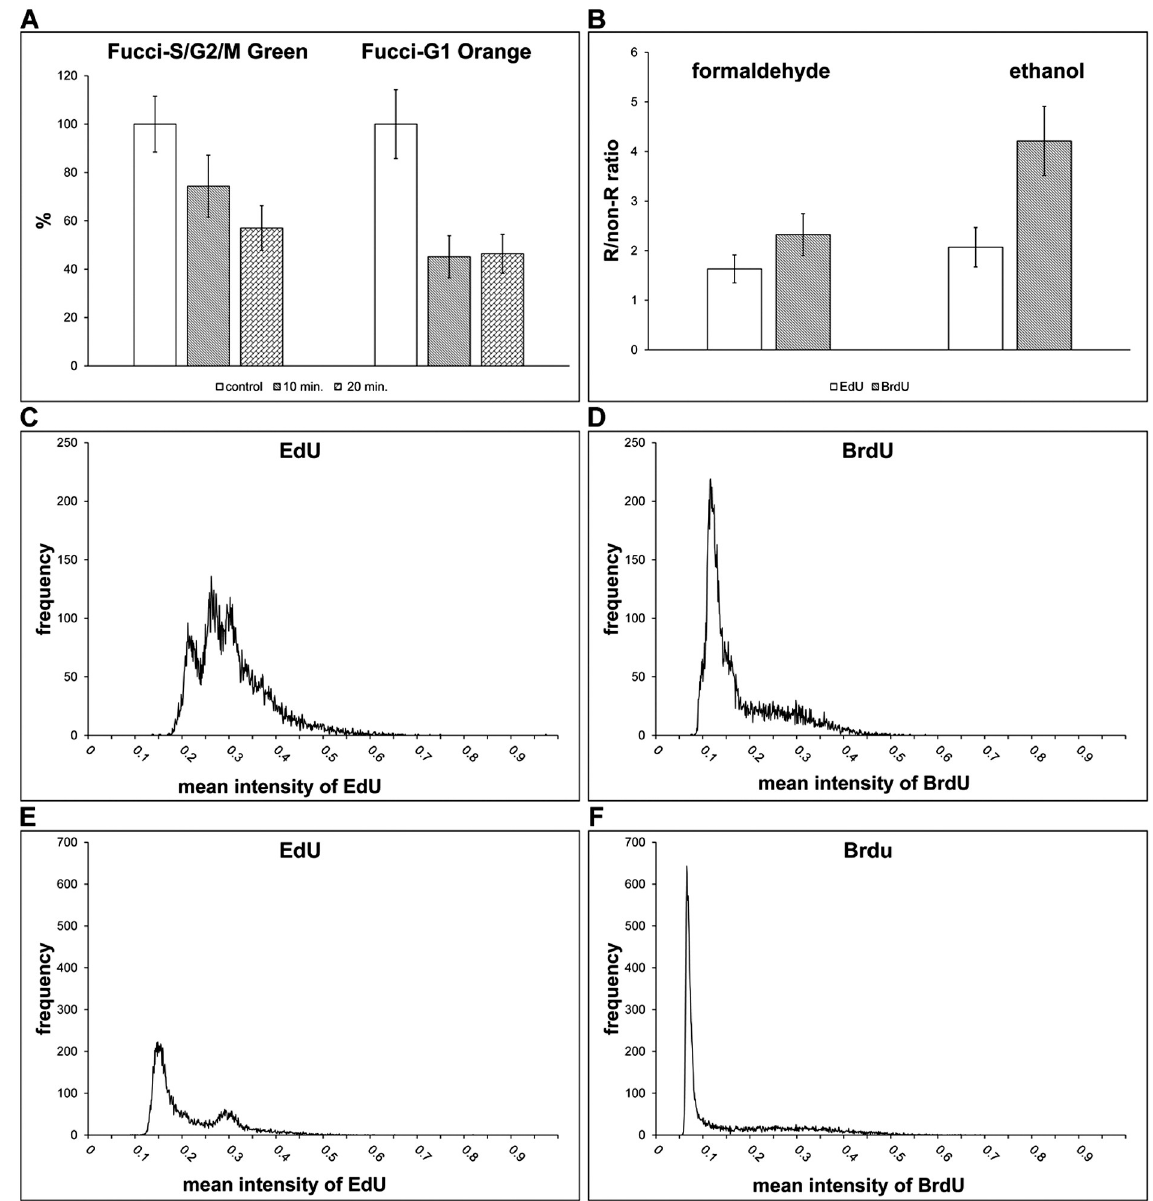
Fig 3. Fluorescent proteins detection and comparison of replicational signal after short pulses of BrdU and EdU. (A) The impact of the optimisedmethod on fluorescentproteins is shown. HeLa cells expressingFUCCI were incubatedwith or without BrdU for 30 minutesand the detectionof BrdU using the optimizedmethod was performed. The cells were treated with HCl either for 10 or 20 minutes. The averagesignalof fluorescent proteins was measuredin cells. The data were normalisedto the % of the average signalof Fucci-G1 Orange and Fucci-S/G2/M Green in control, non-treated, cells. The data are presented as the mean ± SD. ( B) The comparison of the signal in cells labelledwith 10 μ M EdU or BrdU for 5 minutes. The graphsshow differencesbetweencells incubatedeither with EdU or BrdU and fixed either with formaldehyde or ethanol. The data are presented as the mean ± SD. ( C, D) The histograms of the mean nuclear EdU- (C) or BrdU-derived(D) signalsin formaldehyde-fixed cells labelledwith 10 μ M EdU or BrdU for 5 minutes. ( E, F) The histograms of the mean nuclearEdU- (E) or BrdU-derived (F) signals in ethanol-fixed cells labelled with 10 μ M BrdU or EdU for 5 minutes.